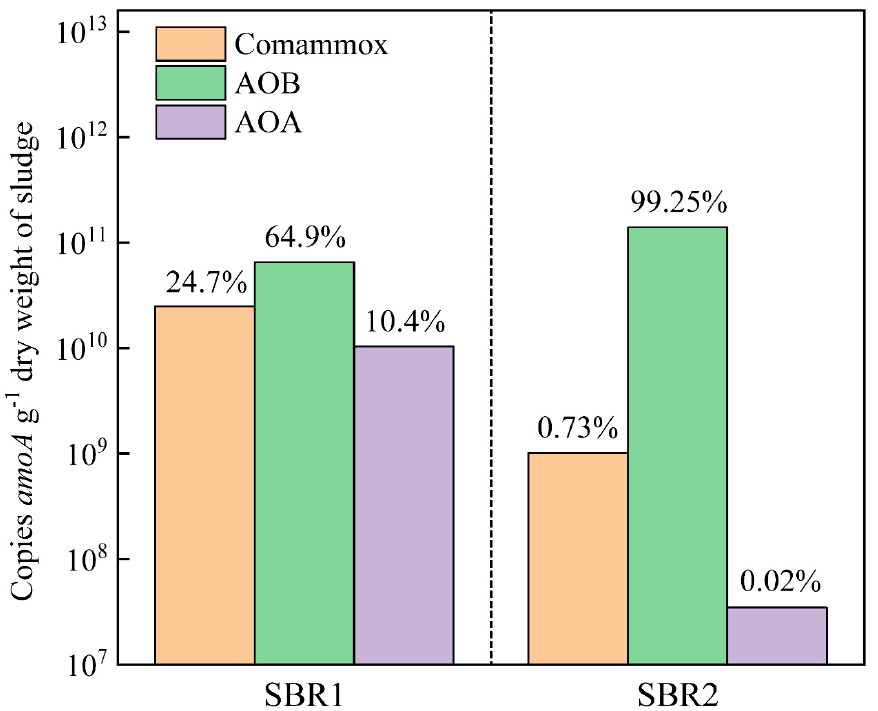
Figure 5. Abundances of amoA genes from comammox, ammonia-oxidizing bacteria (AOB) and ammonia-oxidizing archaea (AOA) in activated sludge samples of both SBRs. Percentages of co- mammox, AOB and AOA in ammonia-oxidizing prokaryotes (AOPs) were displayed above the corresponding columns.